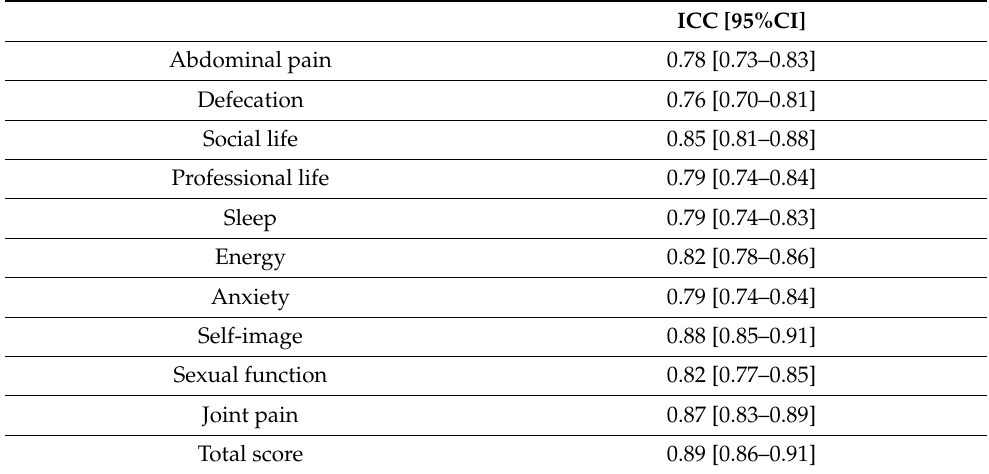
Table 2. “Test-retest” reliability of the IBD-Disk: Intraclass correlation coefficients for each item and the total IBD-Disk score ( n = 300).